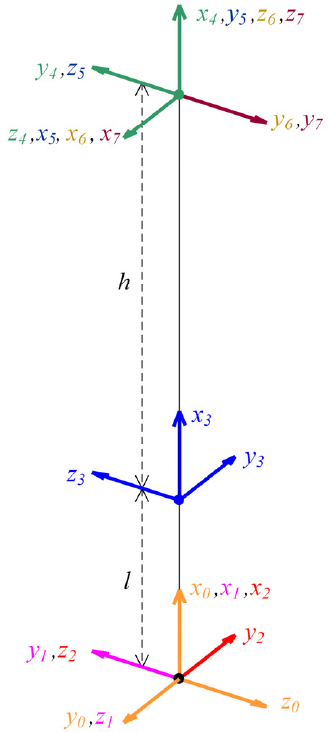
Figure 3. Arm Coordinate System. Table 1. Arm’s Parameters in D-H Transformation Matrices.